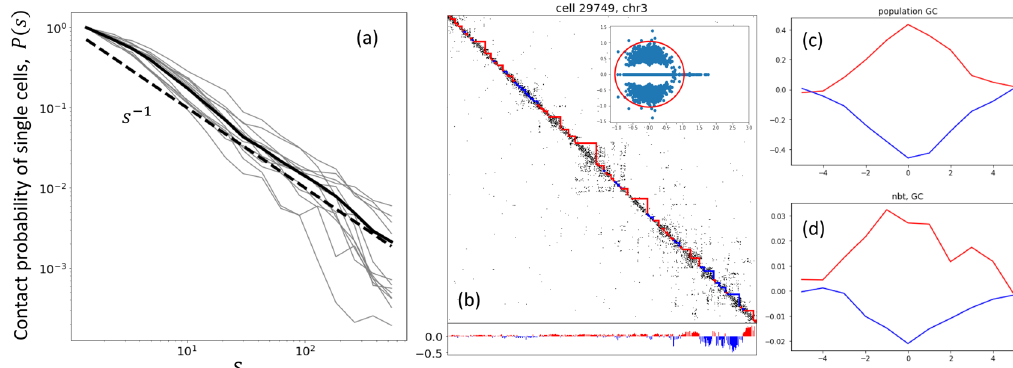
Figure 4. ( a The average contact probability P ( s ) of single cells (gray) and of the merged cell (solid, black) computed for logarithmically spaced bins with the logfactor 1.4; the fractal globule scaling P ( s ) shown by dashed line for comparison. ( b ) Annotation of active (red) and inactive (blue) compartmental domains for one of the contact maps (cell 29749, chromosome 3, length N polymer non-backtracking flow operator. Below the map the compartmental signal from the corresponding leading eigenvector of the polymer non-backtracking flow matrix is shown. Inset: the full spectrum of the polymer flow for the same contact map. ( c , d ) Averaged profiles of the GC content (z-scores) plotted around